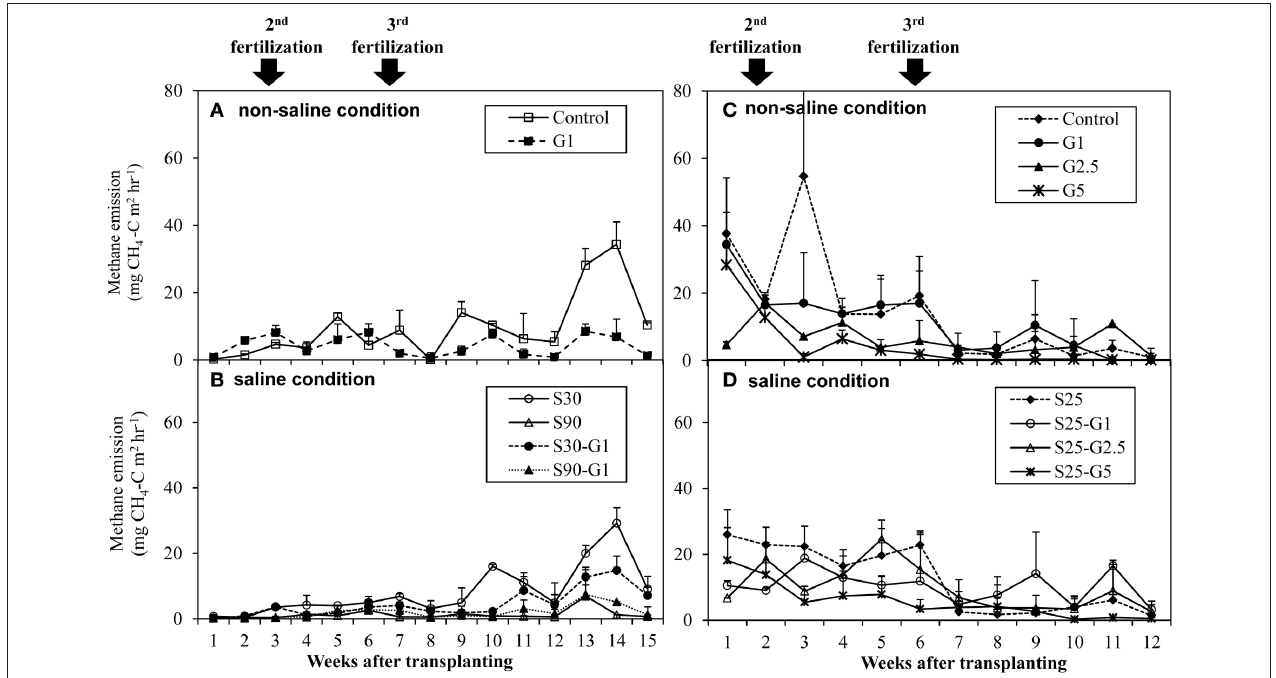
FIGURE 4 | Average CH 4 emission rate under non-saline condition and saline condition; (A,B) represents Experiment (I), and (C,D) represents Experiment (II). Error bars indicate standard deviation.